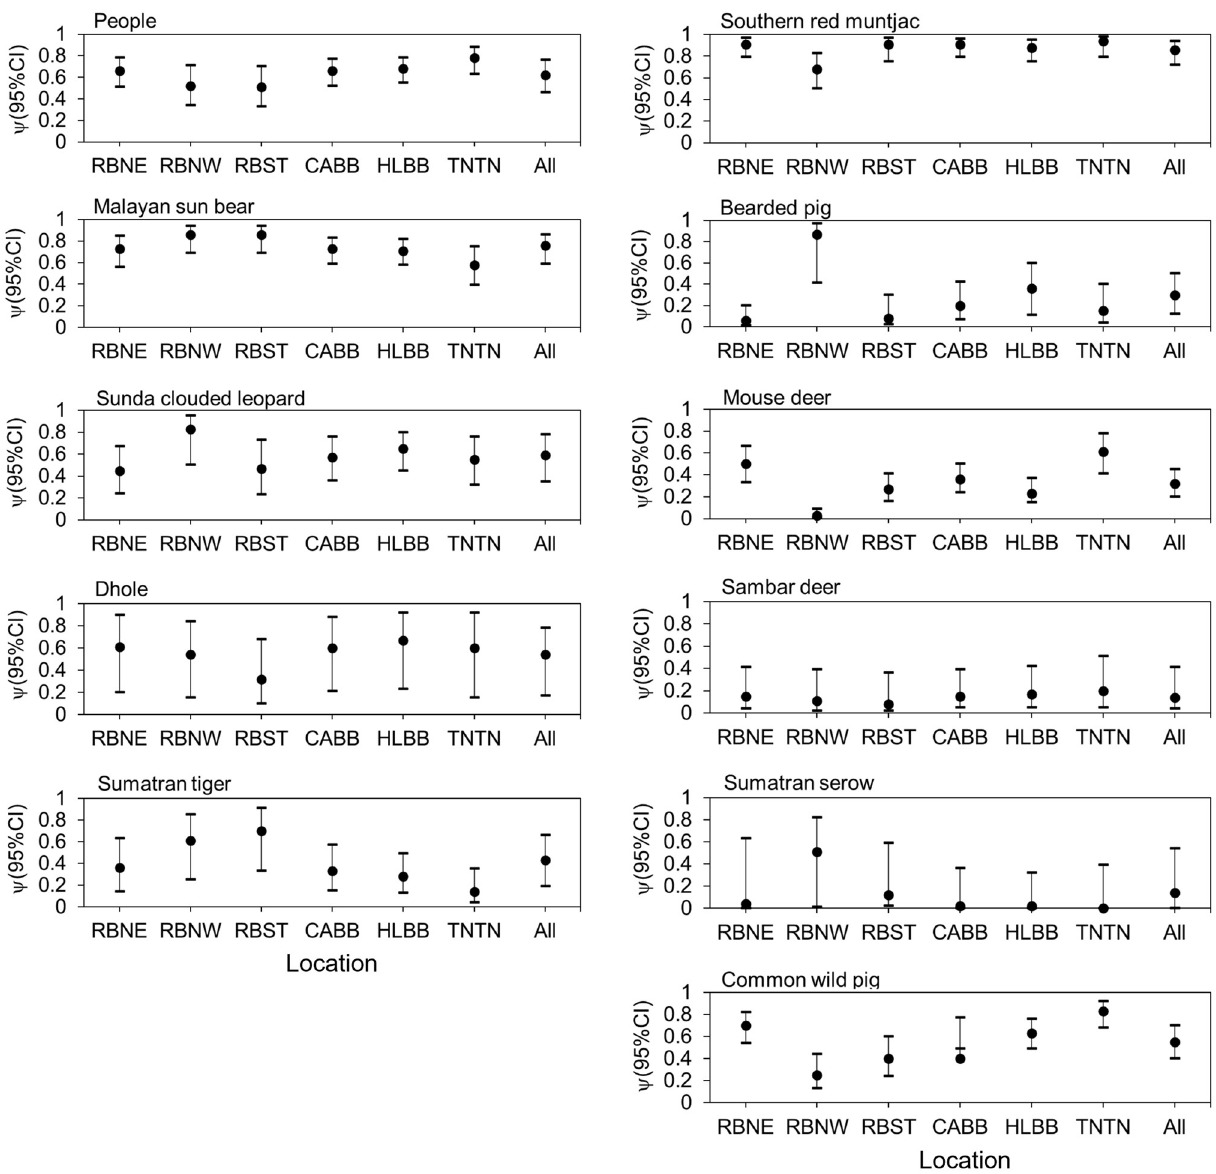
Fig 2. Probability of occupancy ( ψ ) with 95% CI based on model averages for top models with Δ AICc � 2: People, large carnivores, and potential prey species for 147 camera stations across all study sites. RBNE, Northeastern Bukit Rimbang Bukit Baling; RBNW, Northwestern Bukit Rimbang Bukit Baling; RBST, Southern Bukit Rimbang Bukit Baling; CABB, Bukit Bungkuk; HLBB, Bukit Betabuh; TNTN, Tesso Nilo; All, “All study